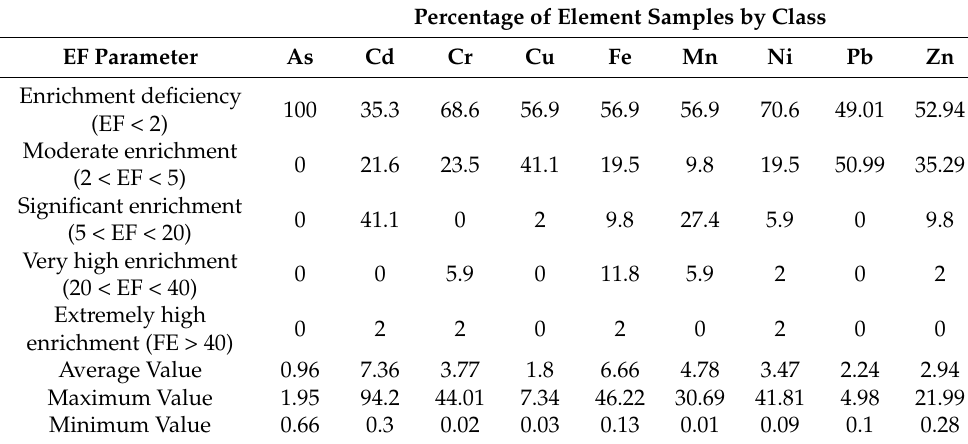
Table 6. Percentage of samples observed in each EF class by element and basic statistical values of sediment samples from the Conceiç ã o river basin.